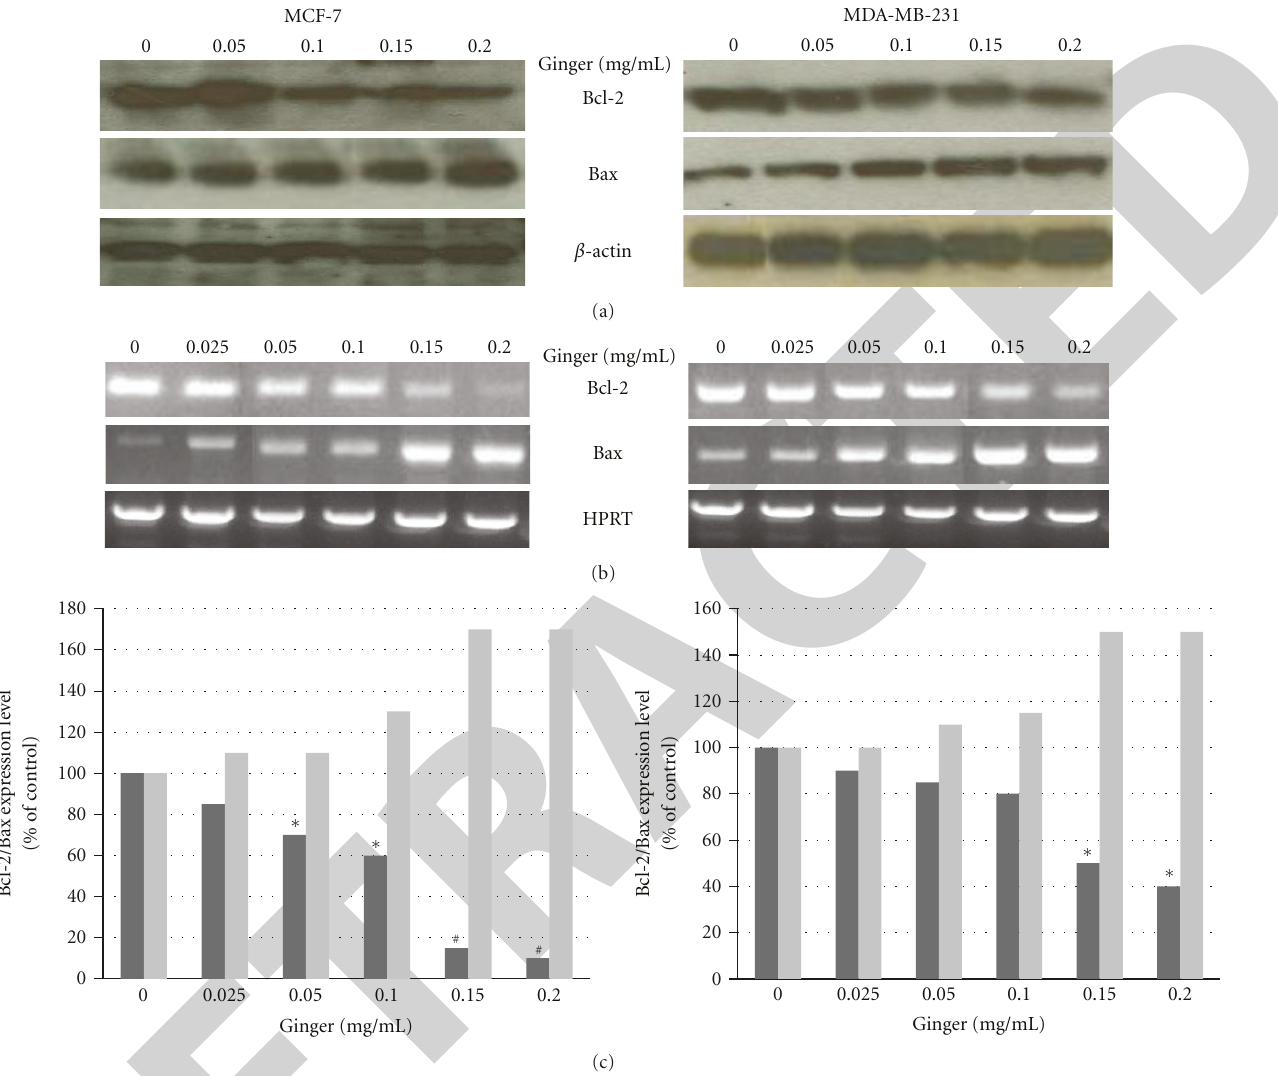
Figure 4: Ginger extract modulates expression of the apoptosis-related proteins. The MCF-7 and MDA-MB-231 cells were incubated with the indicated concentrations of the ethanol extract of ginger for 24h. (a) Cell lysates were prepared and examined for the expression of Bcl-2 and Bax proteins by western blot as described in the Materials and Methods. β -actin was used as the internal control. Representative blots from three independent experiments are shown. (b) The total RNAs were isolated, reverse transcribed, and subjected to PCR with the Bcl-2- and Bax-specific primers. The PCR products were then subjected to electrophoresis in 1% agarose gel and visualized by EtBr staining. HPRT was used as the internal control. A typical result from three independent experiments is shown. (c) The histogram depicts the Bcl-2 (dark bars) and Bax (light bars) mRNA ratio in MCF-7 and MDA-MB-231 cells measured by using densitometric analysis, P < 0 . 05 ( ∗ ); P < 0 . 001